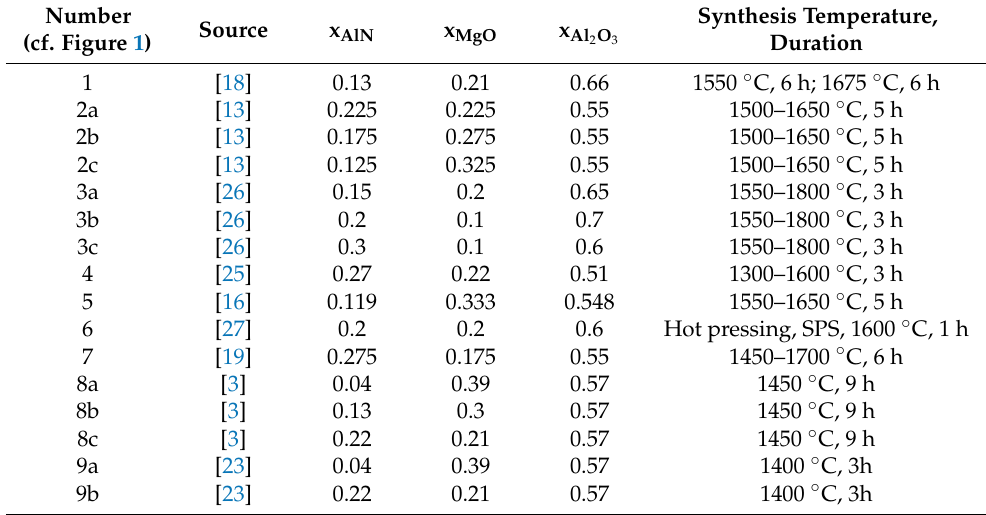
Table 1. Starting compositions (mole fractions) of AlN, MgO, and Al 2 O 3 used in literature for reactive sintering of